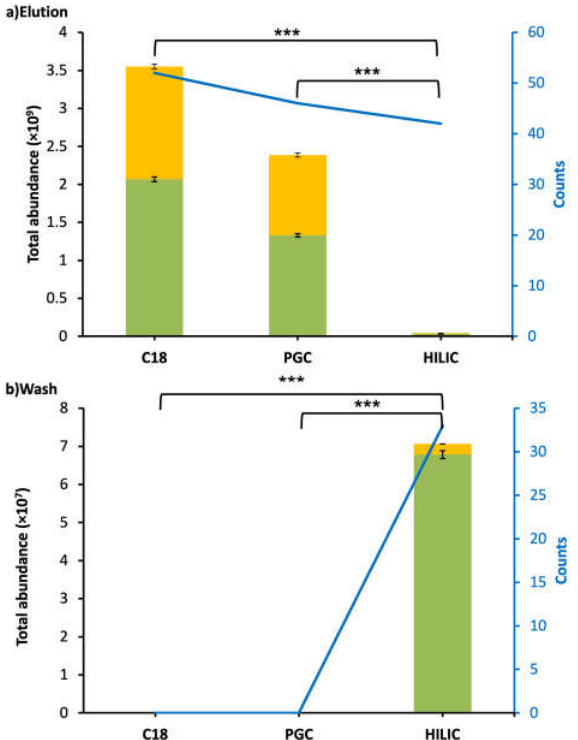
Figure 1. Bar graphs and line charts (blue) of total abundance and counts of CMP and CMP-derived peptides found in WPI after C18, PGC, and HILIC SPE. Abundances were based on the total peak abundances of all of the CMP and CMP-derived peptides. ( a ) Elution fraction. ( b ) Wash fraction. Peptides with O-glycan(s): yellow; peptides without O-glycan(s): green. Asterisks indicate statistically significant differences; *** means p ≤ 0.001.